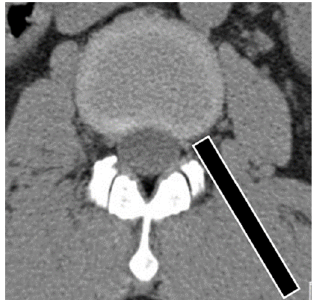
Figure 2. Angle of endoscopic trajectory for the upper lumbar area is steeper than that of the lower lumbar area for the prevention of neurological tissue injury.